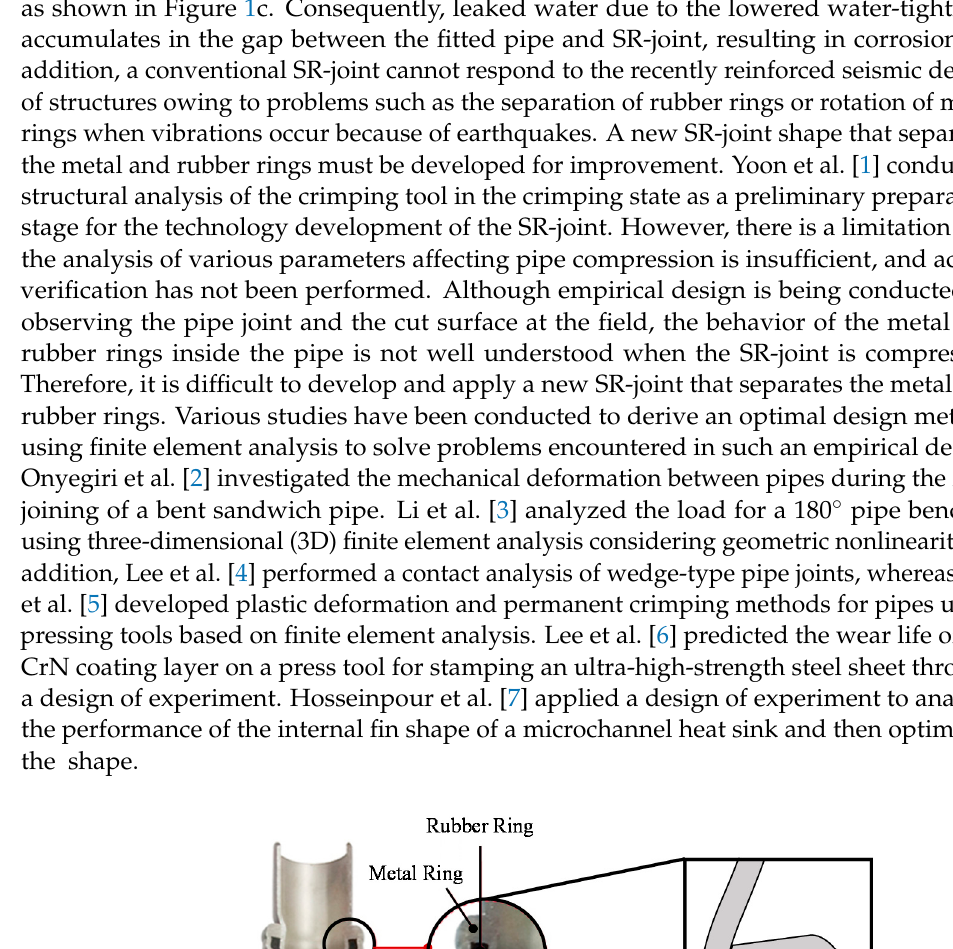
Figure 2. Schematic diagram of SR-joint.